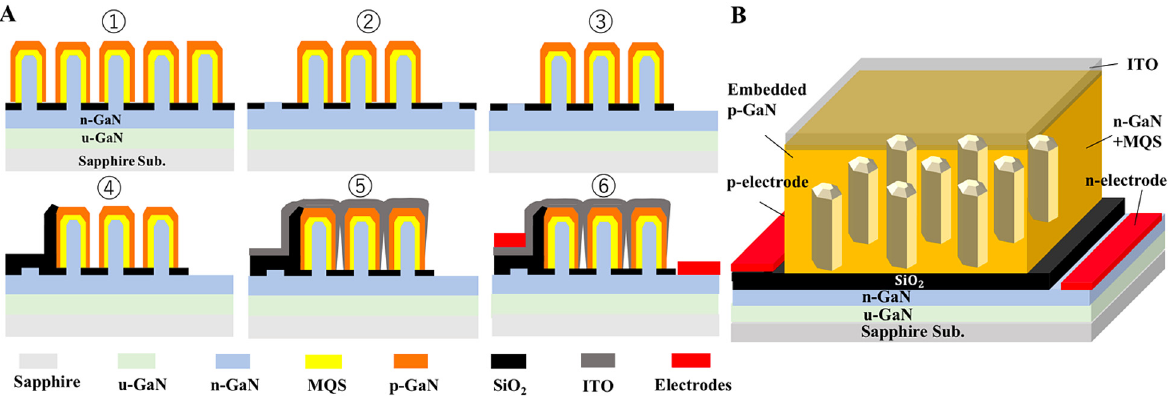
Figure 1: Schematic diagram of the fabrication process for NW-LEDs and device structure in sample c. (A) Schematic of the device fabrication flow for nanowire (NW)-based light-emitting diodes (LEDs) in the sample a: ① as-grown NW structures are actively annealed for 30 min under the ambient nitrogen and oxygen; ② NWs on the electrodes are removed by ultrasonic cleaning or dry etching; ③ n -GaN bulk at the n-electrode is exposed by ICP etching; ④ SiO 2 is sputtered on the p -electrode; ⑤ indium tin oxide (ITO) is sputteredandannealedforcurrentspreadinginthemesaarea; ⑥ Cr/Ni/Au fi lmsaredepositedontheelectrodes.(B)Schematiccon fi guration of a fabricated NW-LED in sample